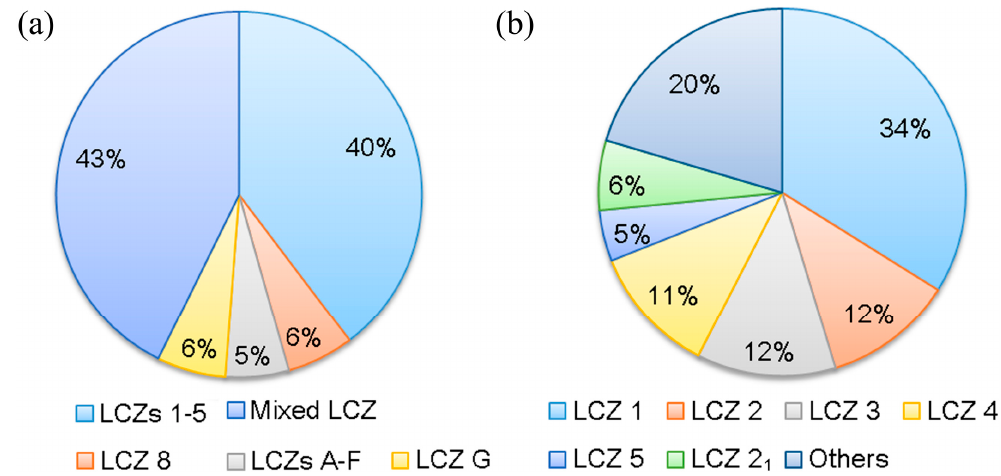
Figure 4. proportion of ( a ) the whole LCZ classification, and ( b ) the built-up LCZs from LCZ 1 to LCZ 5 for the central urbanized area of Guangzhou. “Others” means containing any two types of LCZs 1–5.